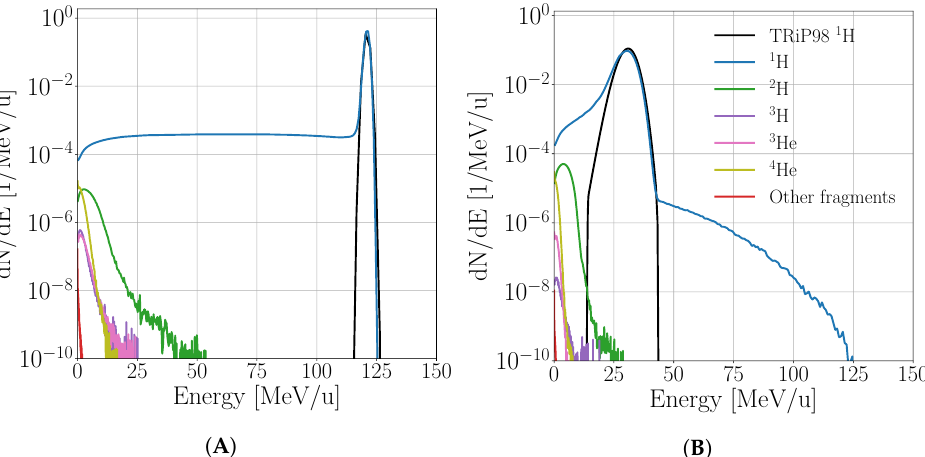
Figure 1. Fluence spectra at 50 mm ( A ) and 158 mm ( B ) depth in semi-logarithmic scale. The black curve represents the currently used spectrum in